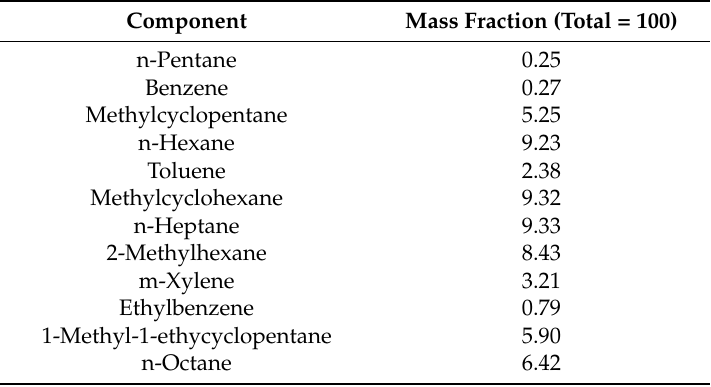
Table 5. Composition of naphtha stream used in the Aspen Plus model.